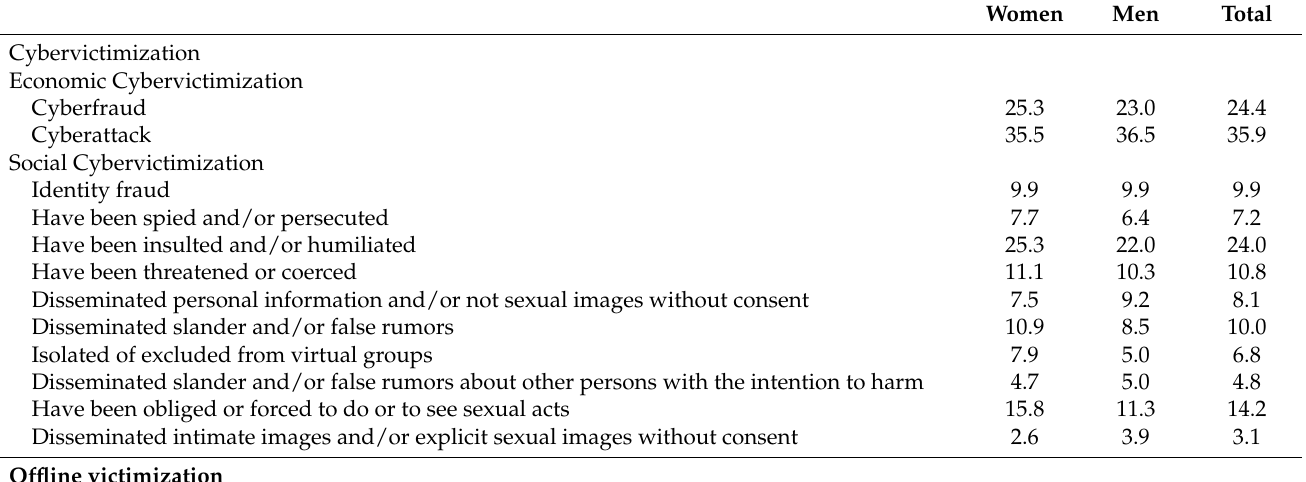
Table 1. Prevalence of cybervictimization and offline victimization (%) ( n =